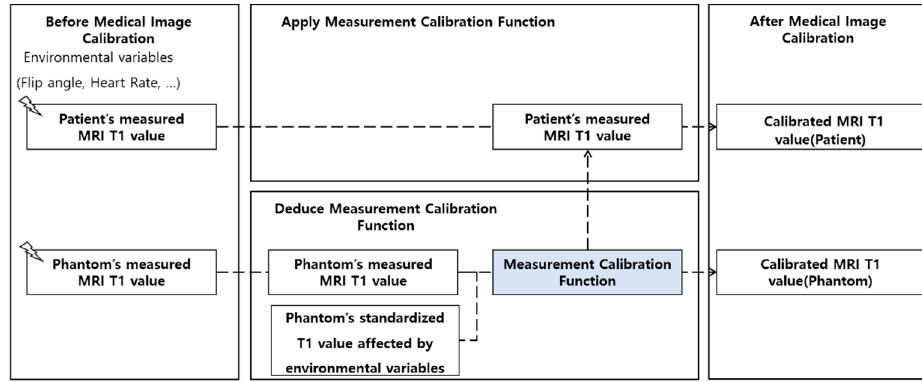
Figure 12. Minimization Process of Measurement Uncertainty in Medical Imaging.